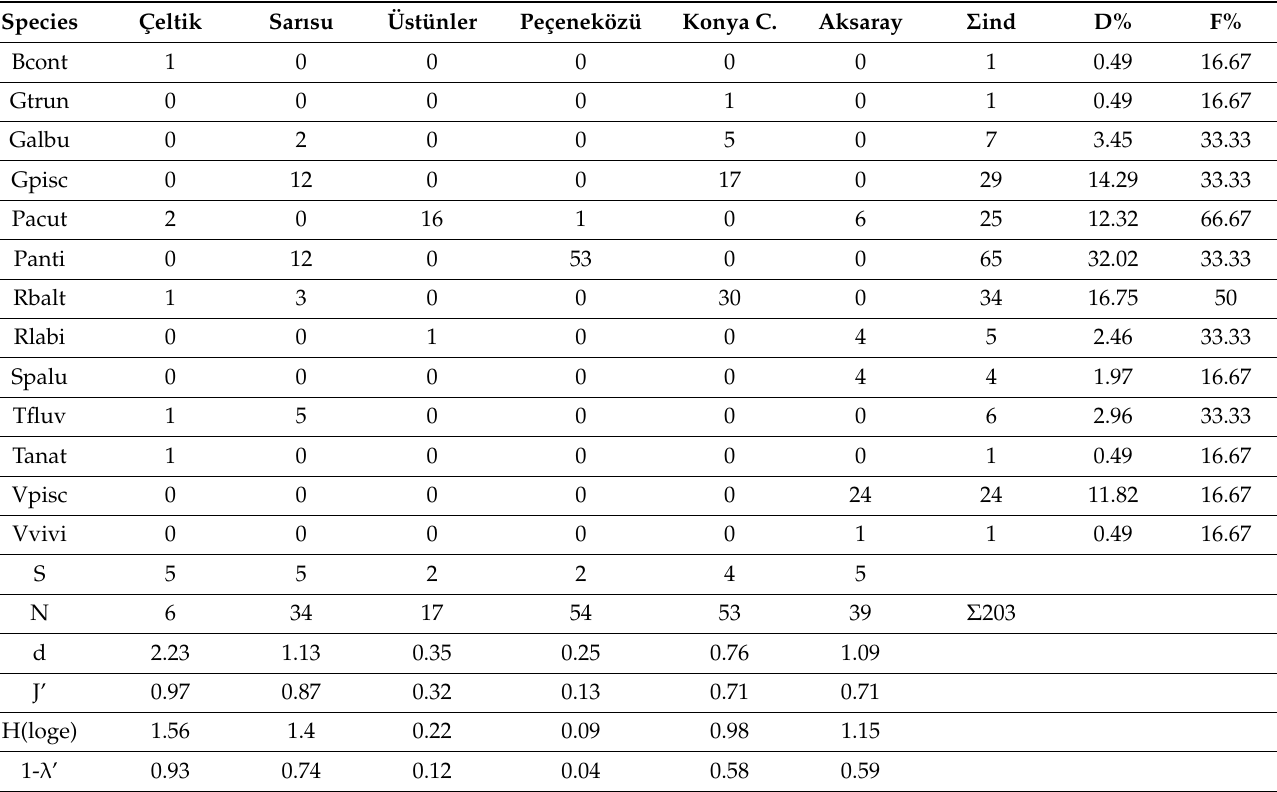
Table 4. Species list, number of identified specimen (individual m − 2 ) at each